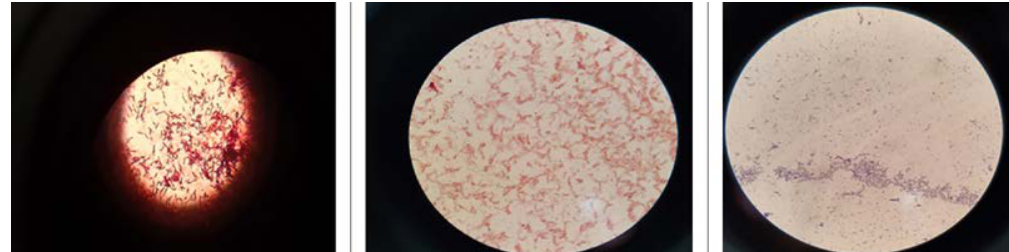
Fig. 5. Gram reaction of the bacterial isolates